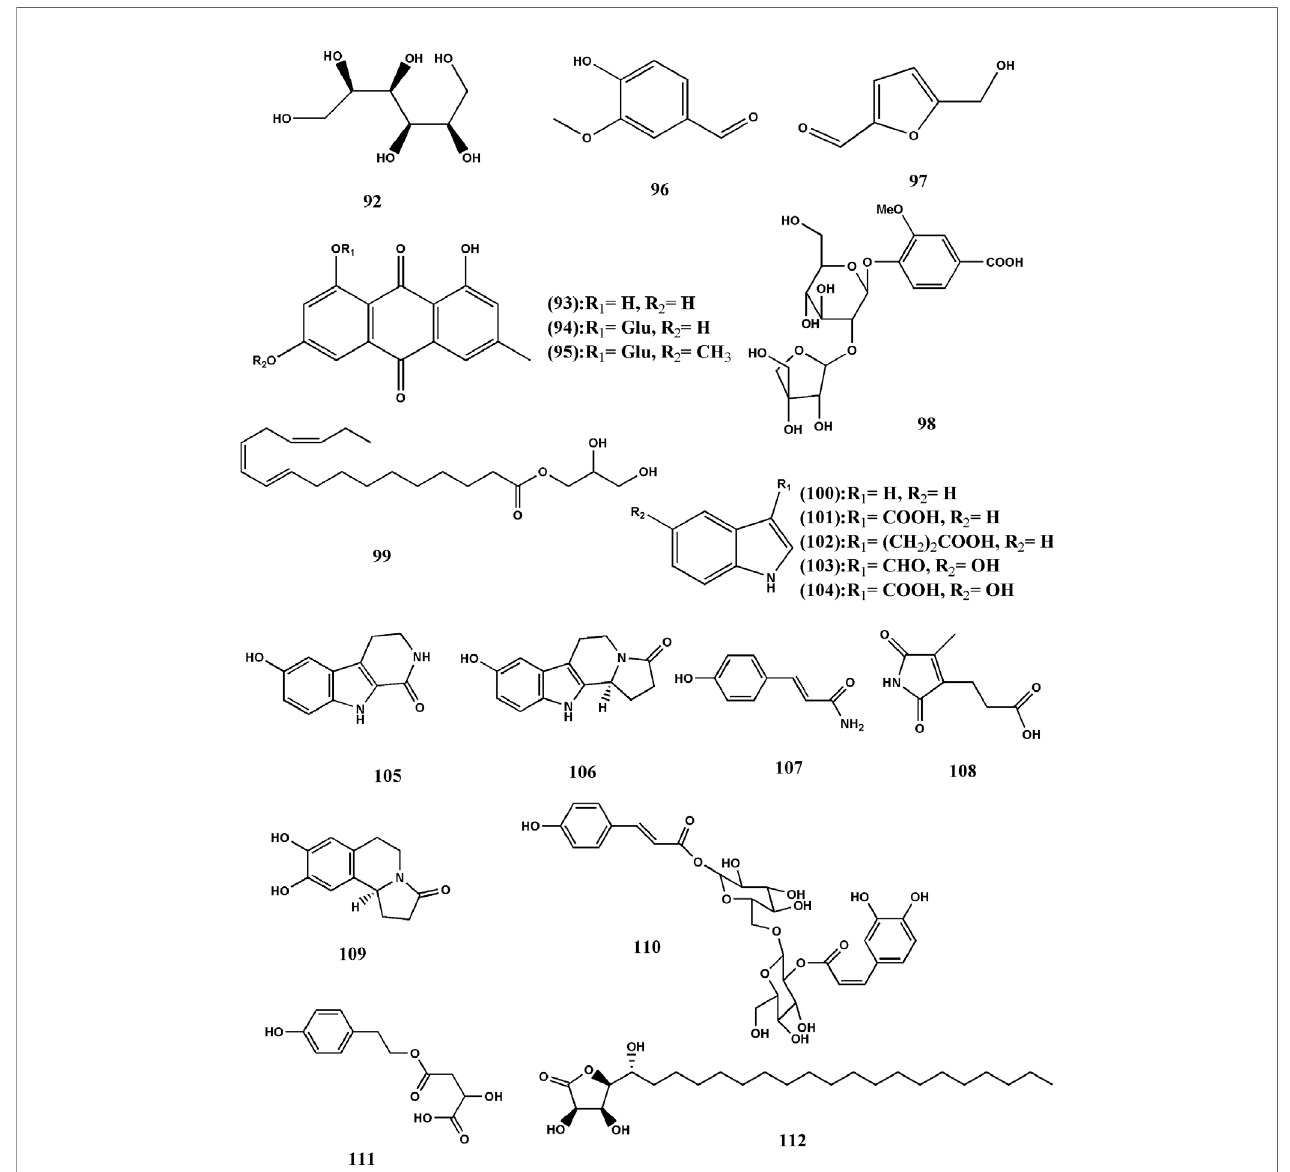
FIGURE 6 | Structures of the anthraquinones, alkaloids, and other components from Tetrastigma hemsleyanum Diels & Gilg. m Tetrastigma hemsleyanum Diels &